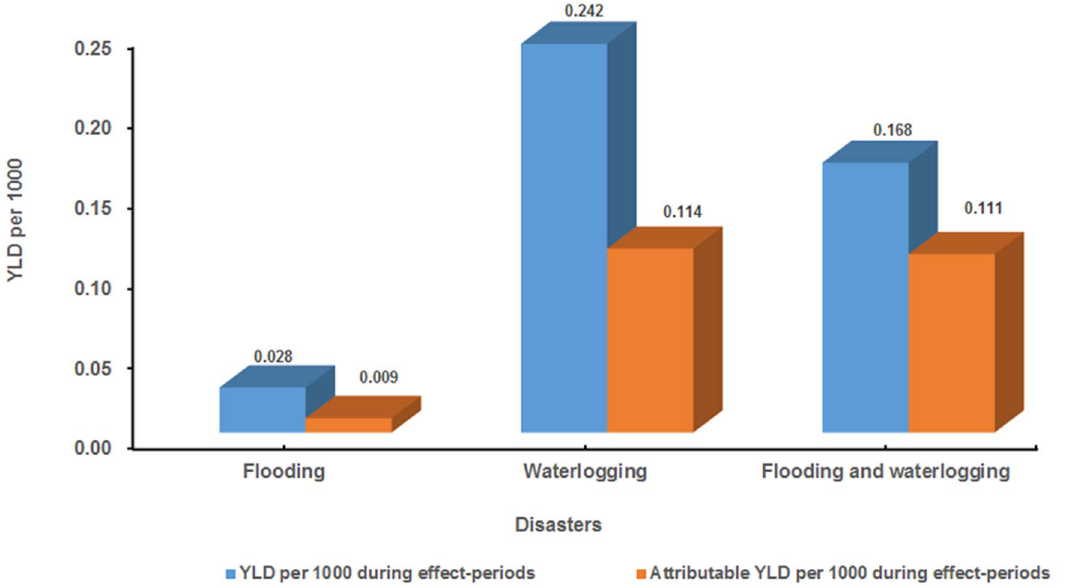
Figure 6. YLD per 1000 and attributable YLD per 1000 of malaria caused by flooding and waterlogging during exposure effect-